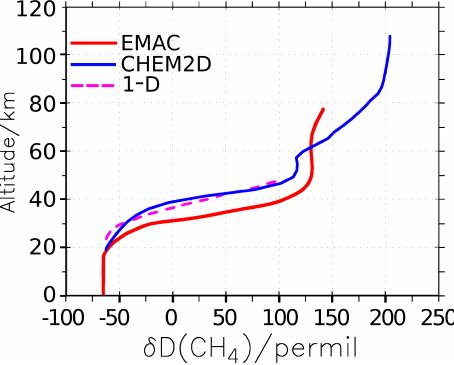
Figure 1. Comparison of equatorial averages of δ D(CH 4 ) with alti- tude between EMAC (red), CHEM2D (blue) by Ridal and Siskind (2002) and the 1-D model (dashed purple) by Ridal et al.